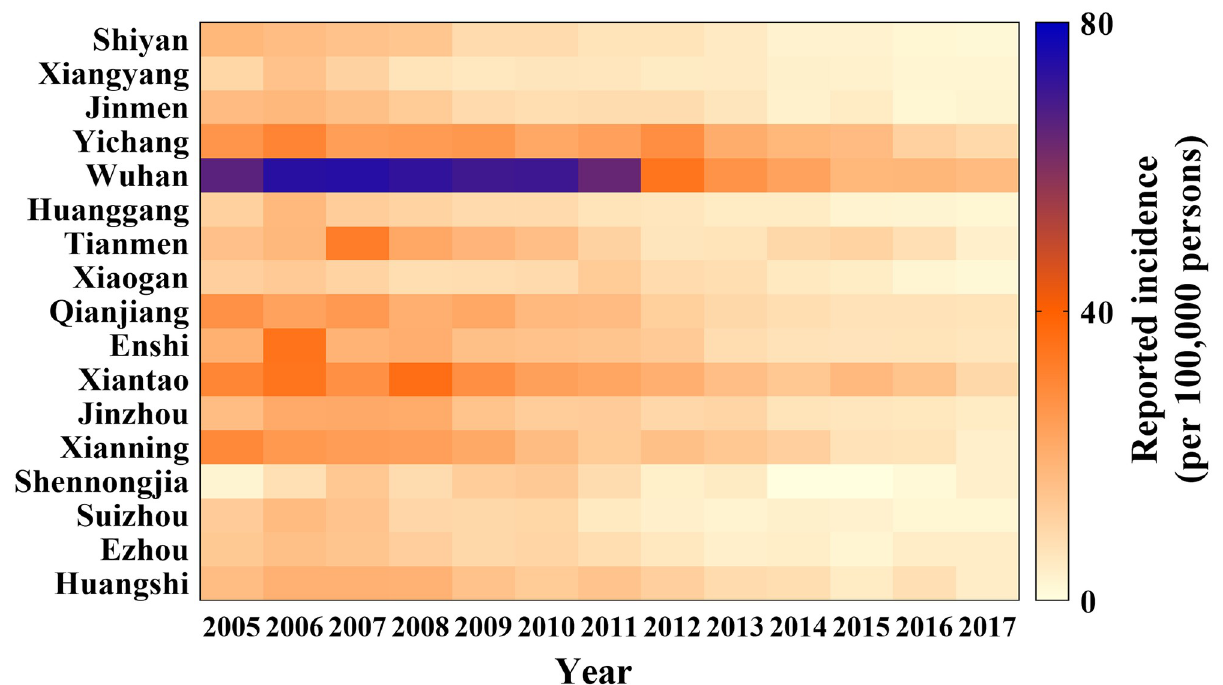
Fig 3. The reported incidence of shigellosis of all cities in Hubei Province from 2005 to 2017.